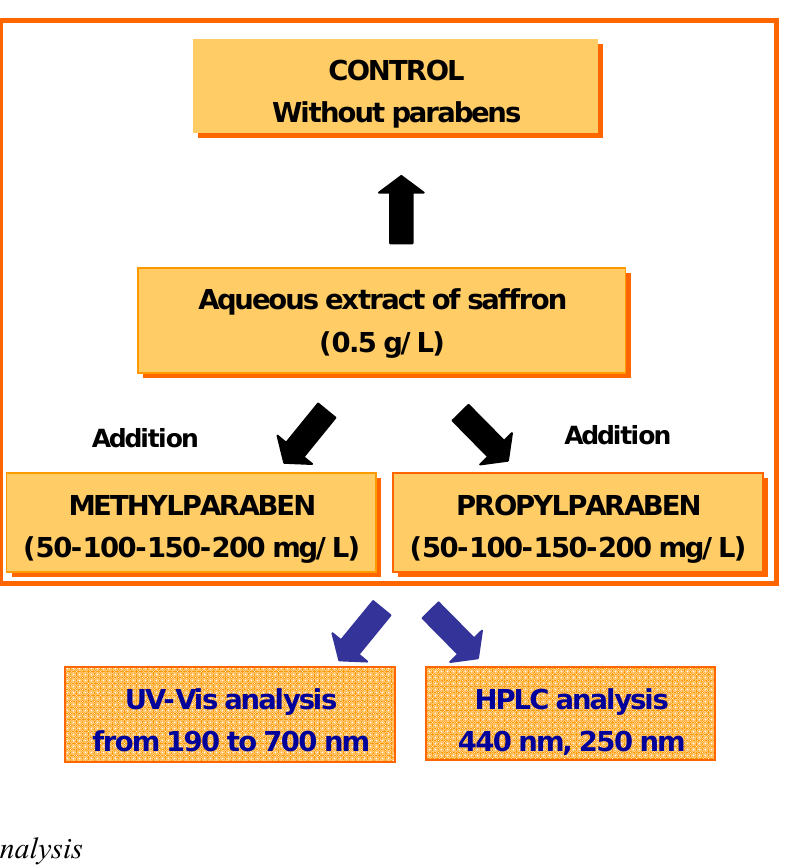
Figure 3. Scheme of